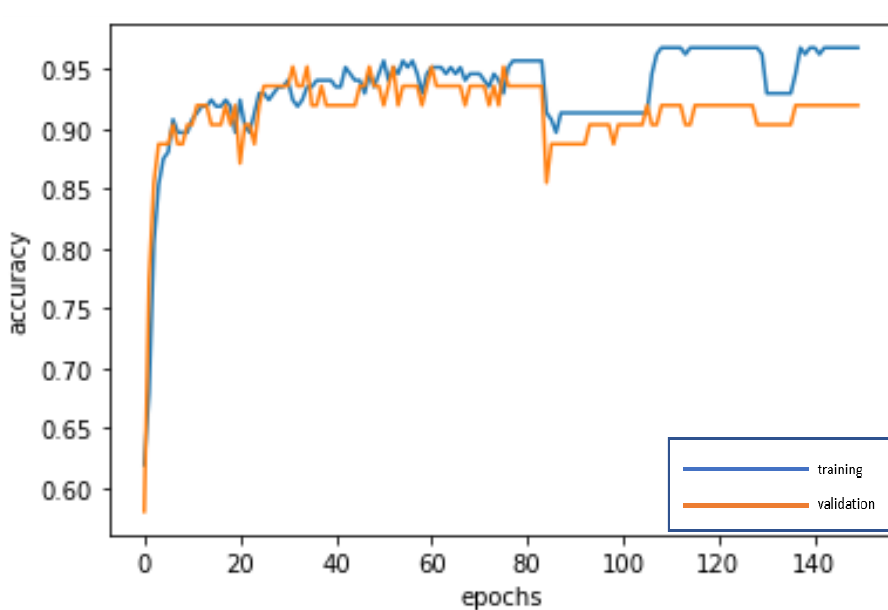
Figure 11. Accuracy line graph of the DNN modeling.